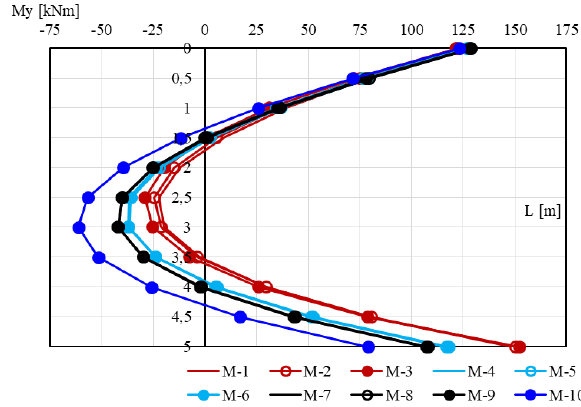
Figure 10: Distribution of bending moments in bridge’s right abutment wall.